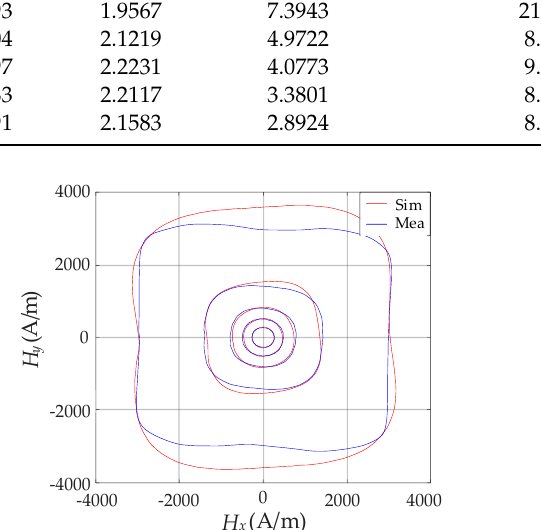
Table 1. Values of parameters and corresponding error extracted by the PSO algorithm.